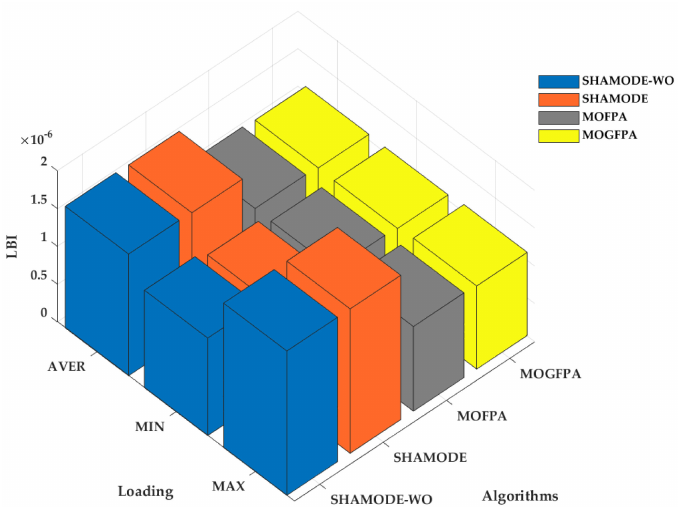
Figure 5. Comparative analysis of LBI for a residential load on IEEE 119 bus system.